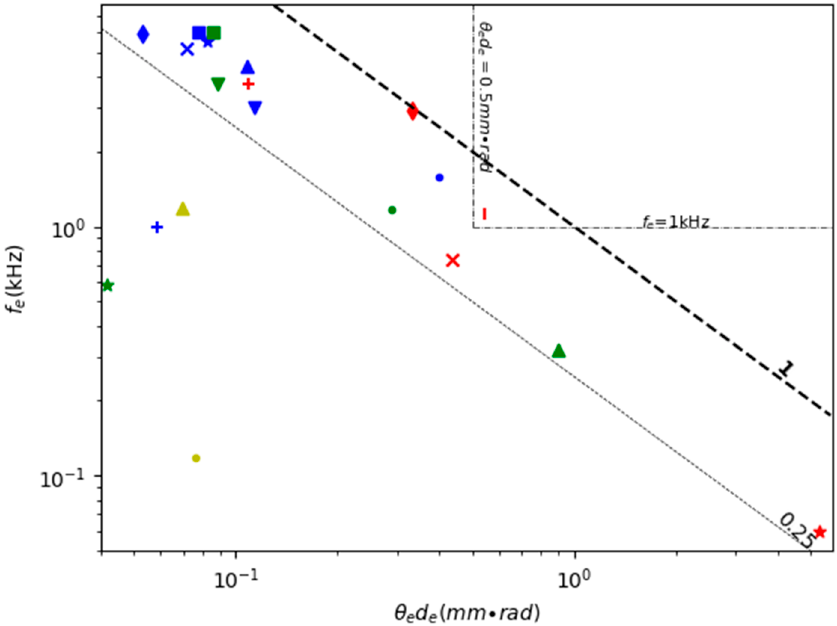
Figure 10. A comparison of 2D double resonant scanning MEMS mirrors.